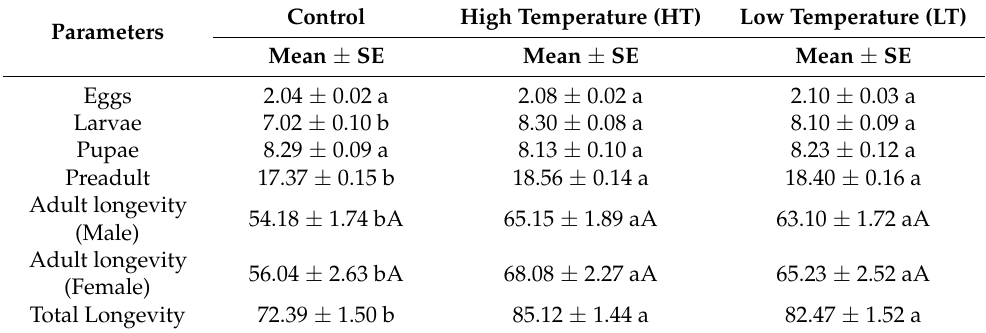
Table 1. Mean ( ± SE) duration of different developmental stages and total longevity (days) of Bactrocera zonata following exposure to high temperature (HT) or low temperature (LT).